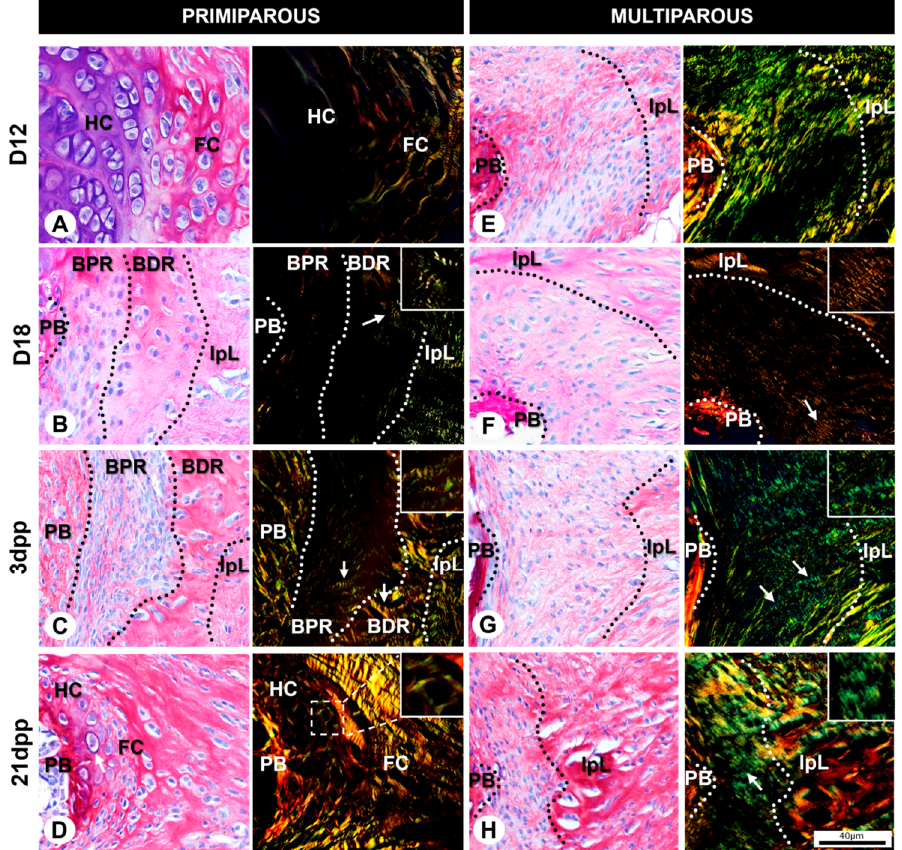
Figure 2. Arrangement of collagen fibers at conventional and polarized light microscopy of symphyseal enthesis in transverse sections during pregnancy and postpartum in primiparous ( A – D ) and multiparous senescent ( E – H ) female mice. ( A ) At D12, observe the transition of the fibrocartilaginous disc (FC) to hyaline cartilage (HC) at the pubic symphysis (PS) architecture. Specifically in the FC, observe the collagen fiber at a perpendicular orientation related to the PS. ( B , C ) By interpubic ligament (IpL) formation, note collagen fiber crimps at the bone proximal region (BPR) and bone distal region (BDR) (arrows and insets). ( D ) At 21dpp, at the restored HC, see the birefringence around cells in their lacunae with a noticeable basophilic territorial matrix (arrow) next to the pubic bone (PB). ( E – H ) Compare the arrangement of collagen fibers at the symphyseal enthesis in the transverse section during pregnancy and postpartum in the multiparous senescent female mice. Note the parallel organization of the birefringent collagen fibers and the presence of crimps (arrows and insets). Sirius Red and hematoxylin staining, scale bar = 40 μ m.